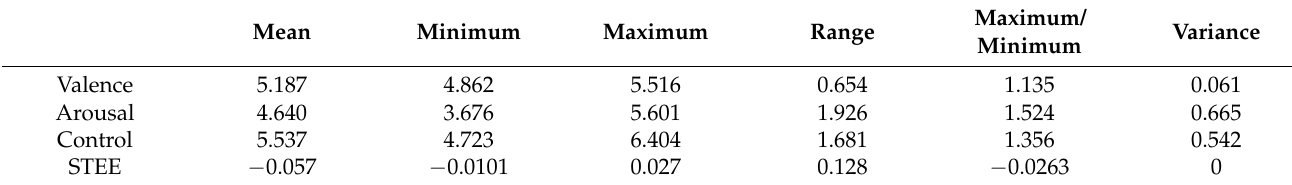
Table 4. Descriptive statistics of third-party evaluations per